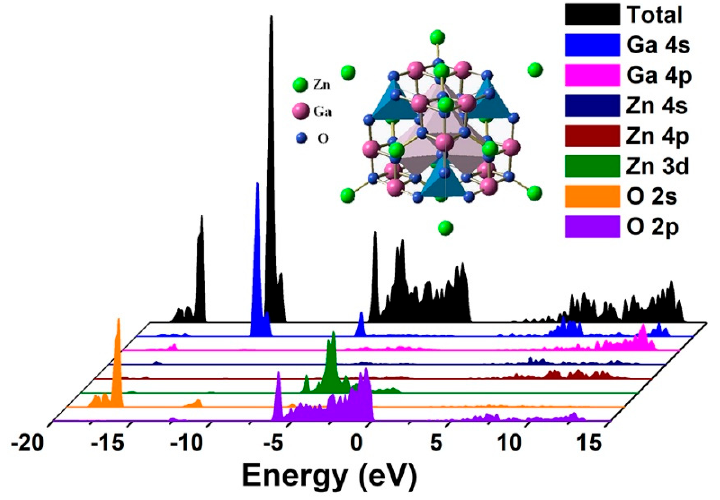
Figure 1. The total and atomic densities of the states of ZnGa 2 O 4.